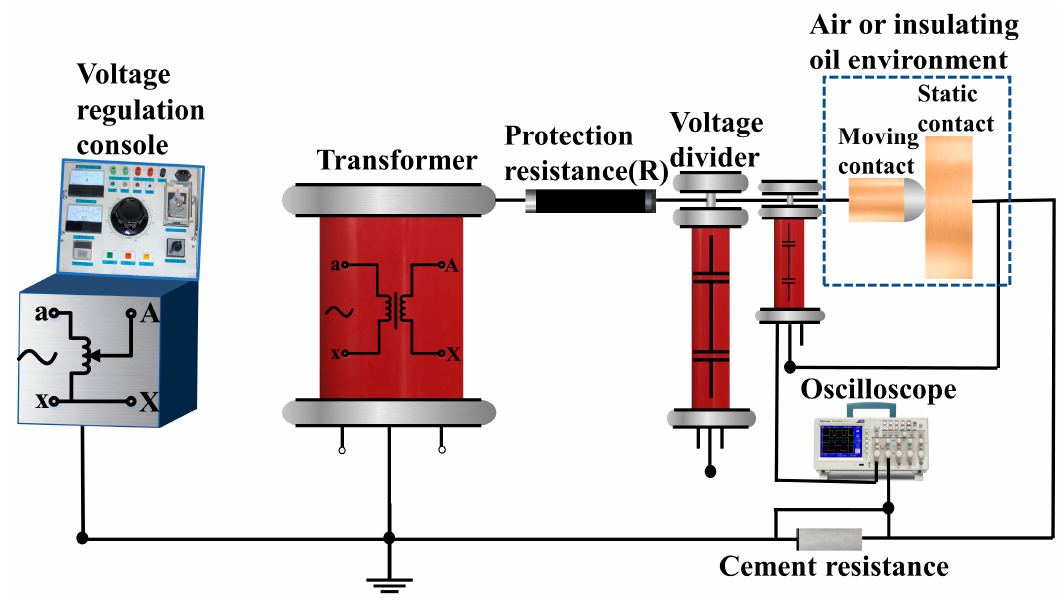
Figure 1. Schematic diagram of the friction and wear testing platform.